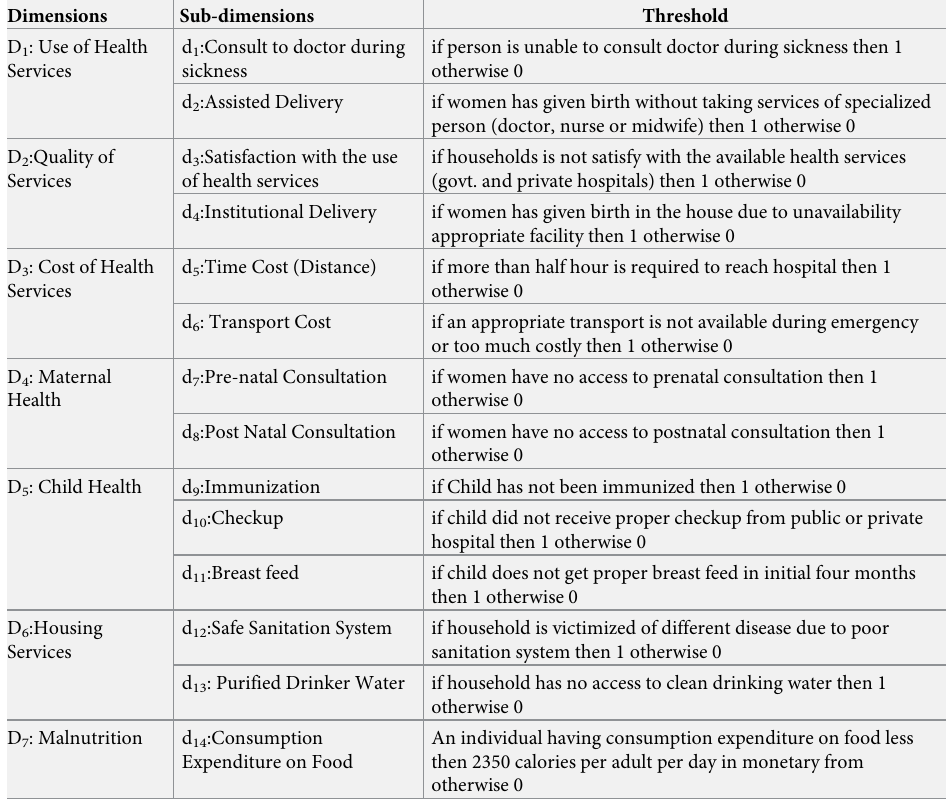
Table 1. Profile of dimensional and sub-dimensional